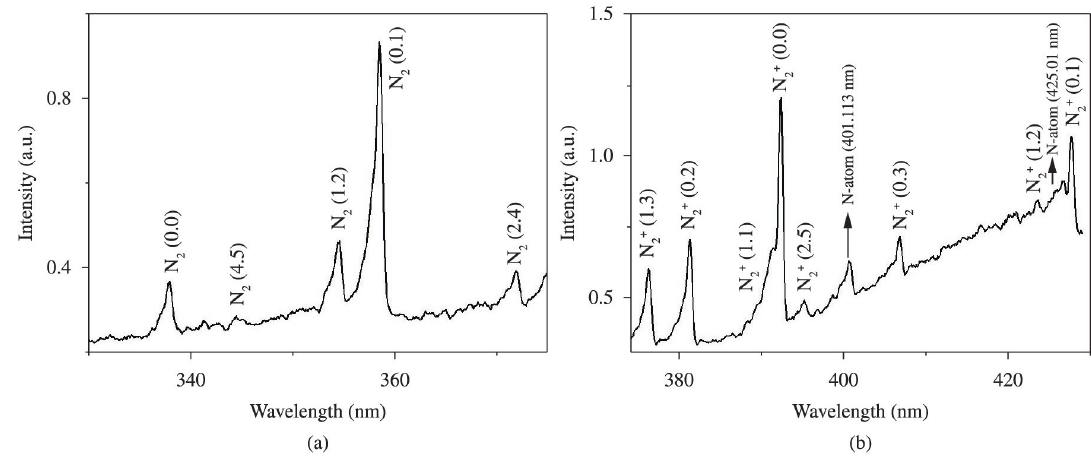
/H plasma at filling pressure of 3 mbar and 5 mAcm -2 curent density in the wavelength range of (a) 2 2